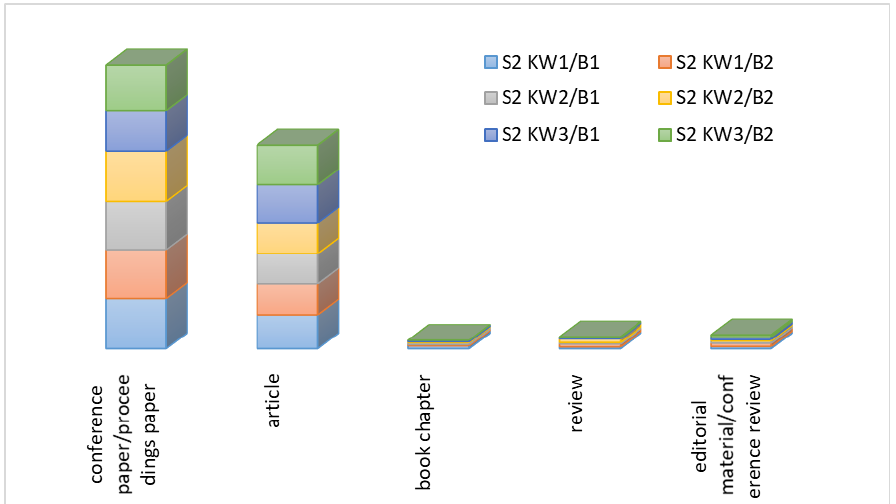
Figure 9. Types of scientific papers for particular keywords (KW) in the segment S2 “Industry 4.0”. Source: Own study based on the databases: Web of Science and Scopus. Table 7. Top 3 most important sources with the largest number of articles for the keywords: “Industry 4.0”, “smart factory” or “smart production”.